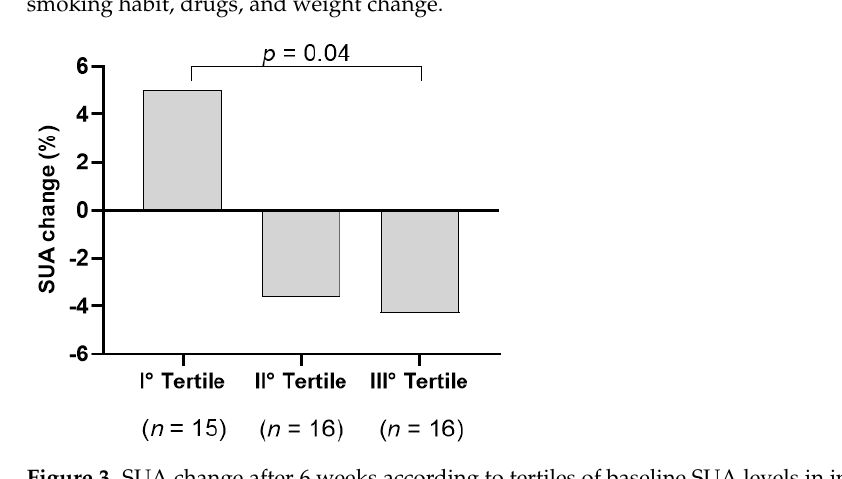
Figure 3. SUA change after 6 weeks according to tertiles of baseline SUA levels in individuals taking